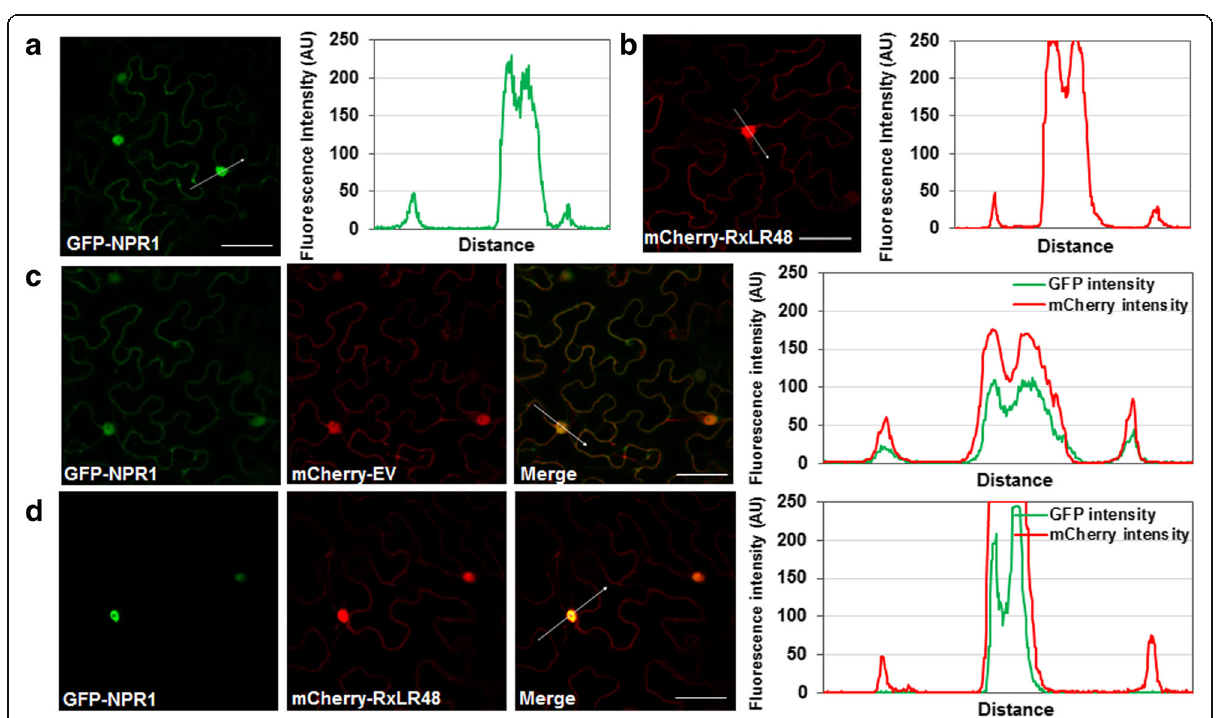
Fig. 4 RxLR48 promotes nuclear accumulation of NPR1. a, b Localization of GFP-fusion of NPR1 and mCherry-fusion of RxLR48 in planta . Confocal images of Nicotiana benthamiana epidermal cells transiently expressing NPR1 ( a ) and RxLR48 ( b ) show the protein localization. c, d Co-localization of NPR1 with mCherry-EV ( c ) or mCherry-RxLR48 ( d ). Indicated combinations were co-expressed in N. benthamiana through agro-infiltration. Fluorescence was detected and photographs were taken at 48 h after agroinfiltration. Scale bar, 50 μ m. The plot of the profile (right) indicated by the white arrow shows the intensity of GFP fluorescence (green line) and mCherry fluorescence (red line)